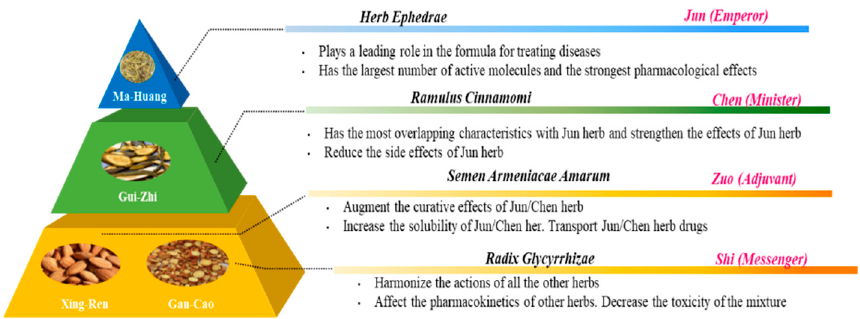
Figure 9. Diagram of the combination principle of Traditional Chinese Medicine (TCM) formula, adapted from Yao et al. [75] and Zhang et al. [76].